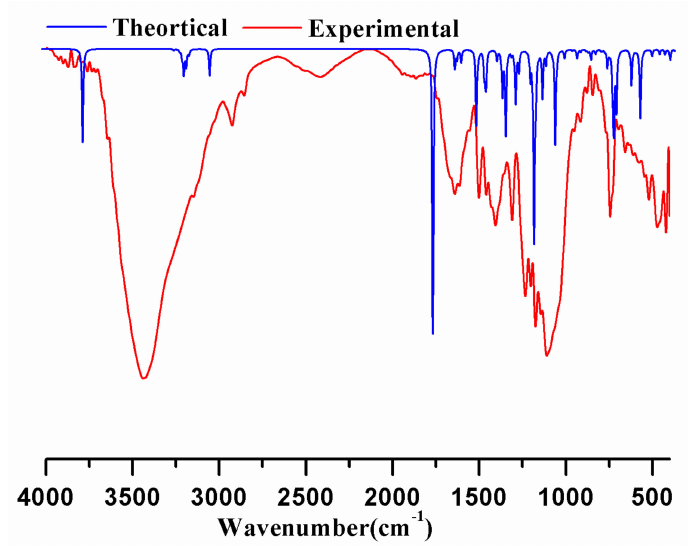
Figure 3. Theoretically calculated FTIR spectrum blue line and experimental infrared spectrum of